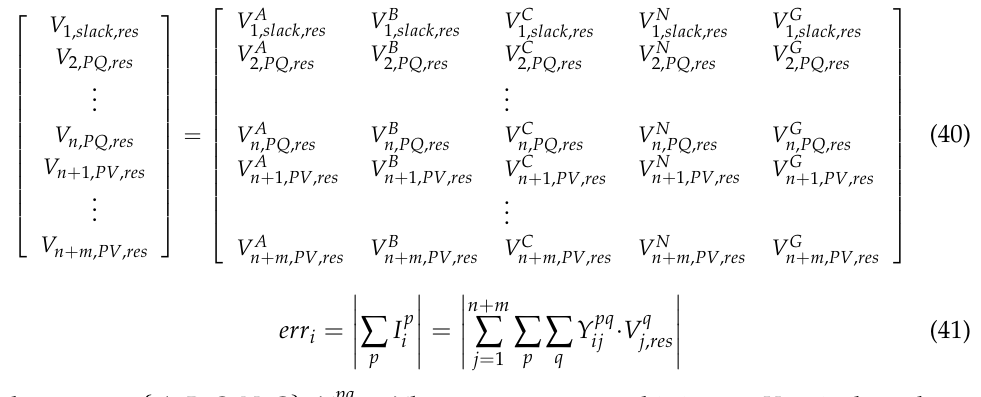
where 𝑝, 𝑞 ∈ {𝐴, 𝐵, 𝐶, 𝑁, 𝐺} ; 𝑌 𝑖𝑗𝑝𝑞 ∈ 𝑌𝑏𝑢𝑠 5(𝑛+𝑚)×5(𝑛+𝑚) and is in pu.; 𝑉 𝑗,𝑟𝑒𝑠 is the voltage re- sult (pu.) in the complex form at node 𝑗 obtained from the voltage and current assess- ments in Section 3.4, or expressed in Equation (40).